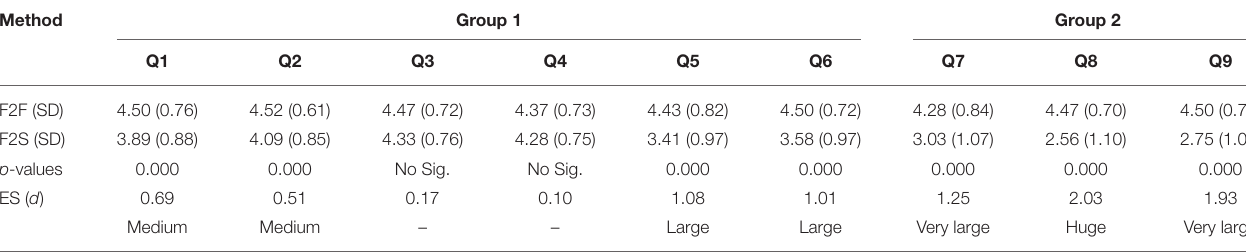
TABLE 7 | Perception comparison between F2F and F2S flipped instruction methodology of the Likert-type test. Method